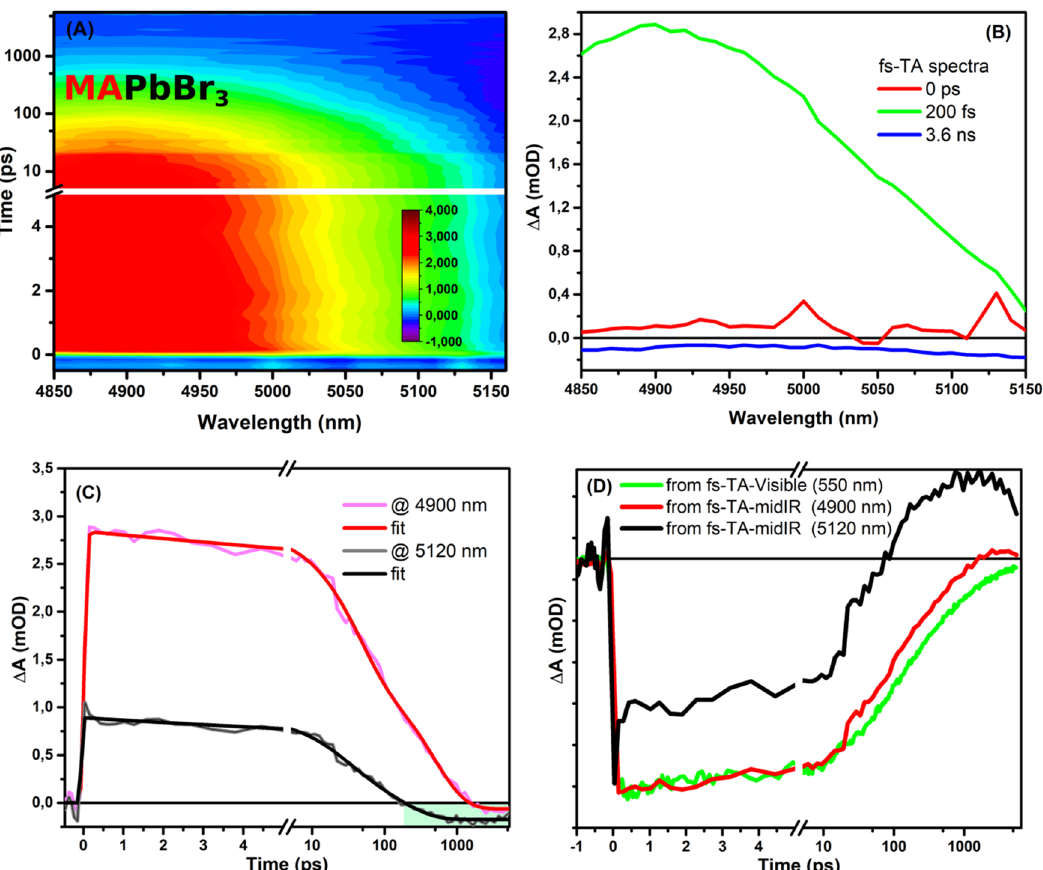
Fig. 1 Transient mid-IR data for MAPbBr 3 fi lm. ( A ) 2D-false color plot of fs-transient absorption in the mid-infrared regions for MAPbBr 3 fi lm using 530 nm as an excitation source. B Extracted spectra for transient spectra in mid-infrared region, the spectra are corrected for the wavelength scale. C Extracted kinetic trace at 4900 and 5120 nm with corresponding fi tting, green shaded area highlights the appearance of negative signal. D Comparison between normalized kinetic traces in the infrared and visible ranges for MAPbBr 3 fi